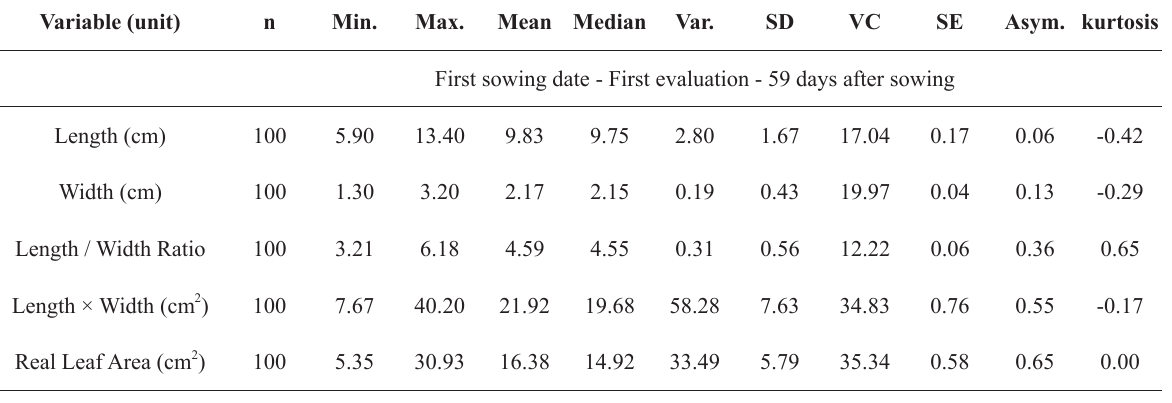
Number of leaves (n), minimum (Min.), maximum (Max.), mean, median, variance (Var.), standard deviation (SD), variation coefficient (VC, %), standard error (SE), asymmetry (Asym.) and kurtosis for evaluated variables in 800 leaves of Crotalaria juncea - measuring 100 leaves by evaluation in each sowing - used only to validate the leaf area estimation models in terms of linear dimensions in the 2014/15 harvest in Itaqui - RS - Brazil. Variable (unit) n Min. Max. Mean Median Var. SD VC SE Asym. kurtosis First sowing date - First evaluation - 59 days after sowing